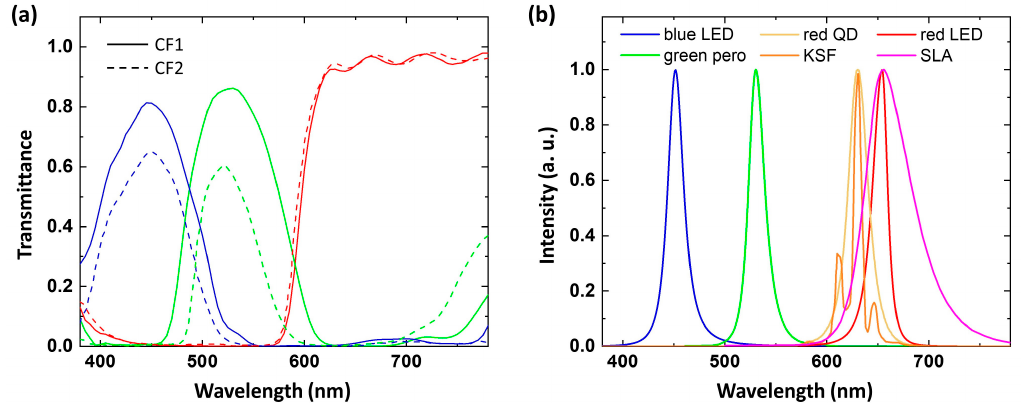
Figure 10. ( a ) Transmission spectra of two commercial color filters. ( b ) Spectra of RGB primaries used Figure 10. (a) Transmission spectra of two commercial color filters. (b) Spectra of RGB primaries used in in optimizations.